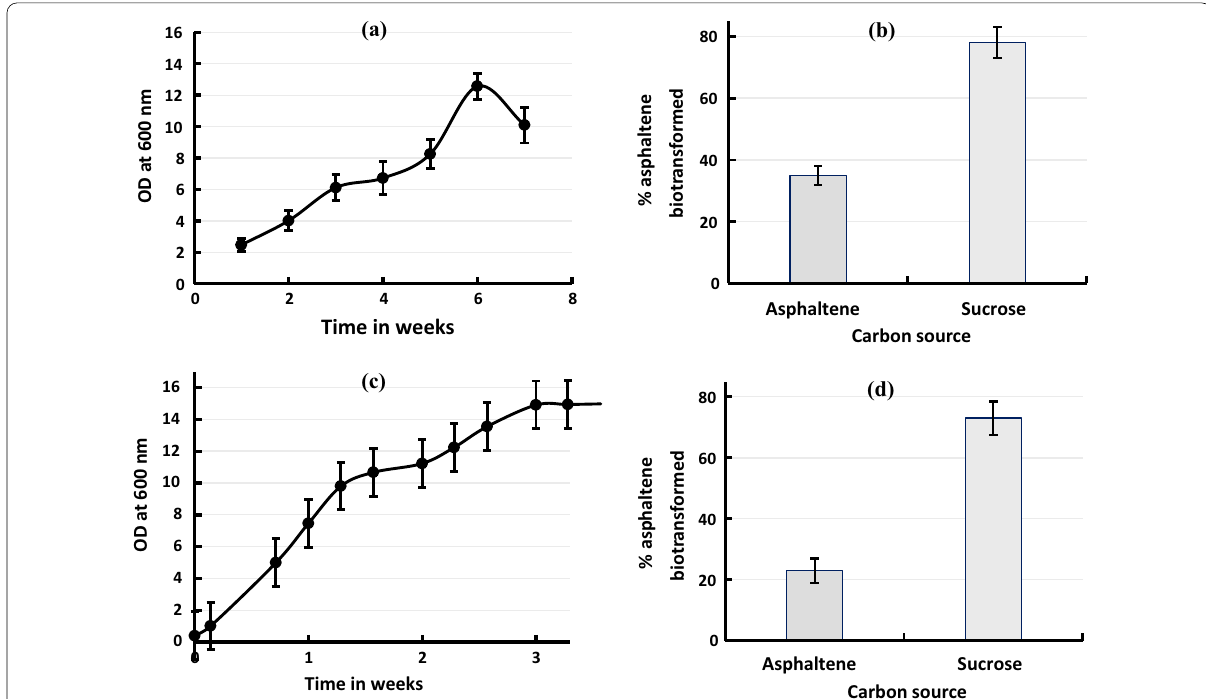
Fig. 1 Asphaltene biotransformation at shake flask level. a Growth profile of consortium in seven weeks growing cell experiment in the presence of both asphaltene and sucrose where the latter is used as primary carbon source. b Percentage asphaltene biotransformation by consortium with respect to controls in seven weeks growing cell experiment. The left bar represents asphaltene alone and the right bar represents asphaltene and sucrose where the latter serves as primary carbon sources. c Growth profile of consortium in 3 weeks growing cell experiment with higher inoculum size in the presence of both asphaltene and sucrose where the latter is used as primary carbon source. d Percentage asphaltene biotransformation by consortium with respect to controls in three weeks growing cell experiment with higher inoculum. The left bar represents asphaltene alone and the right bar represents asphaltene and sucrose where the latter serves as primary carbon